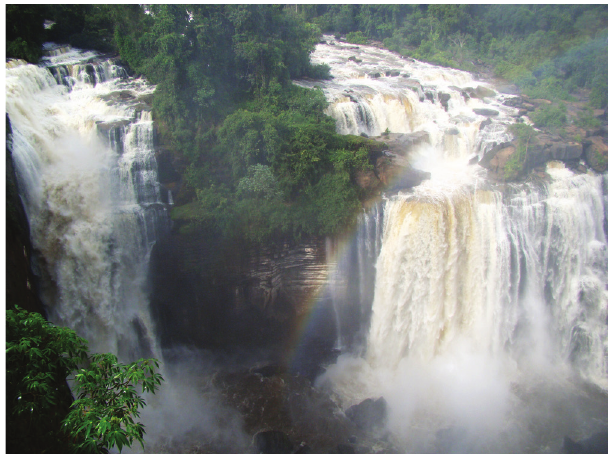
Fig. 4. The cachoeira Dardanelos at the município de Aripuanã, Mato Grosso State, Brazil. This fall is part of a series of close waterfalls descending about 150 m from its upper to the lower levels. This natural feature is known to be a biogeographic boundary for certain groups of